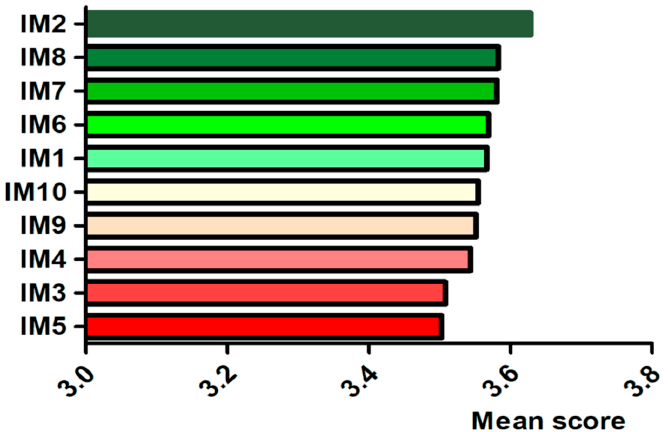
Figure 2. Improvement measures for food safety supervision sampling inspection. Data are